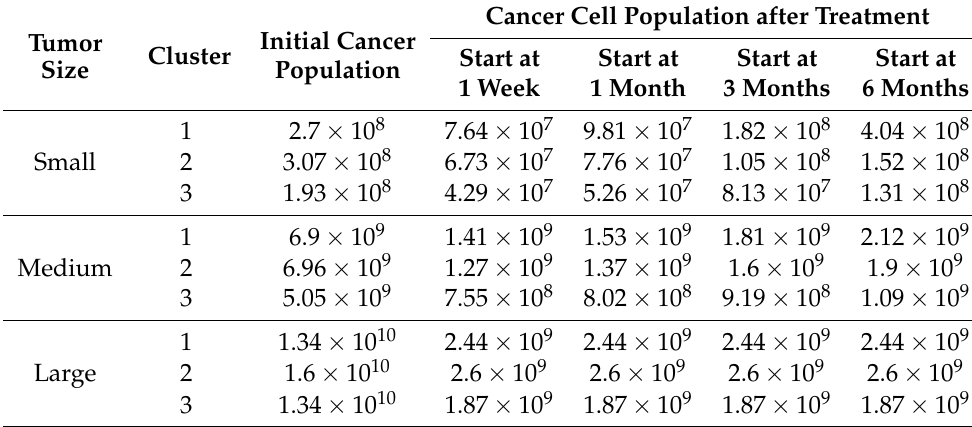
Table 4. Cancer cell populations after MAP treatment with different treatment start times.